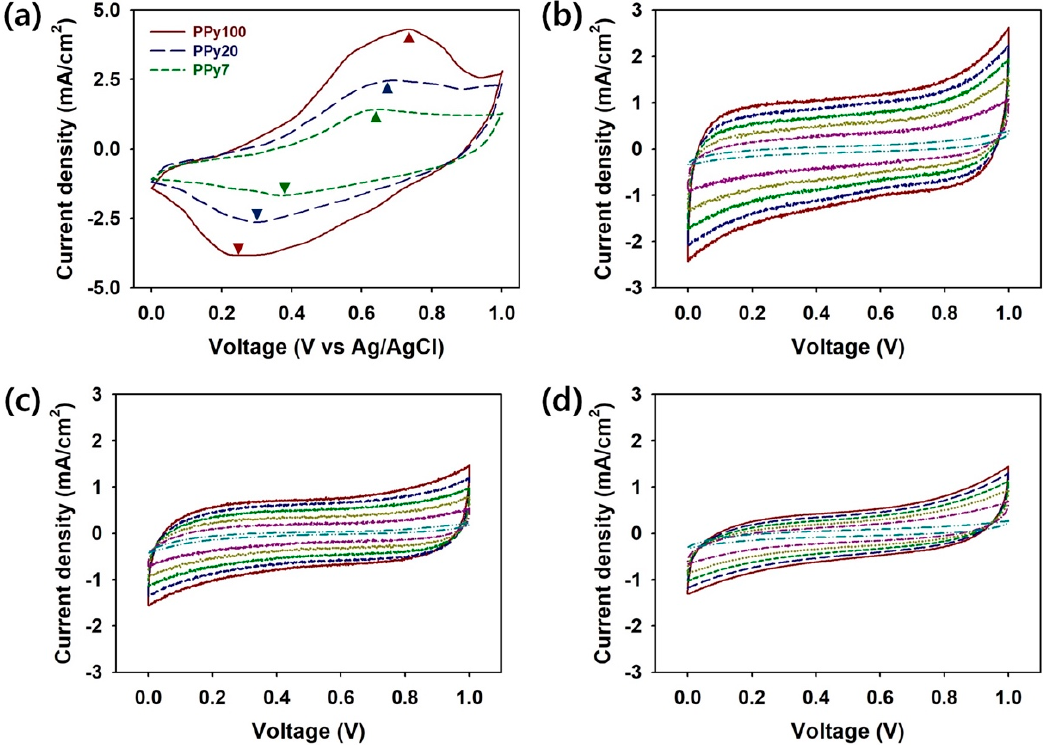
Figure 5. ( a ) Cyclic voltammetry (CV) curves of Polypyrrole:Poly(4-styrenesulfonate (PPy:PSS) with a PSS molecular weight of 1.0 × 10 6 g/mol (PPy100 (red)), PPy:PSS with a PSS molecular weight of 2.0 × 10 5 g/mol (PPy20 (blue)), and PPy:PSS with a PSS molecular weight of 7.0 × 10 4 g/mol (PPy7 (green)) at a scan rate of 20 mV/s in 1 M KOH. CV curves of coin cells employing ( b ) PPy100, ( c ) PPy20, and ( d ) PPy7 at different scan rates: 50 mV/s (red), 40 mV/s (blue), 30 mV/s (green), 20 mV/s (olive green), 10 mV/s (purple), and 1 mV/s (cyan).